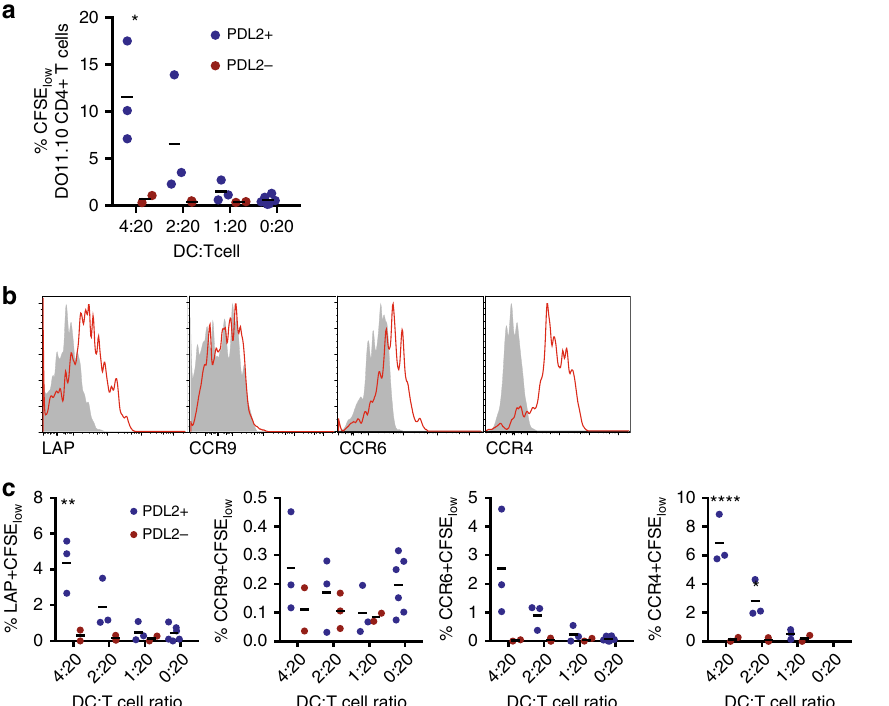
Fig. 7 PDL2 + DCs from skin-draining lymph nodes present antigen. a Percentage of CFSE low DO11.10 CD4 + T cells after co-culture with sorted PDL2 + (blue) or PDL2 − (red) DCs from mice treated with OVA for 48 h. b Representative plots of the expression of LAP, CCR9, CCR6, and CCR4 by CFSE-low DO11.10 CD4 + T cells after co-culture with sorted PDL2 + DCs. Staining control is shown in grey ( fl uorescence minus one). c Percentage of CFSE low LAP +